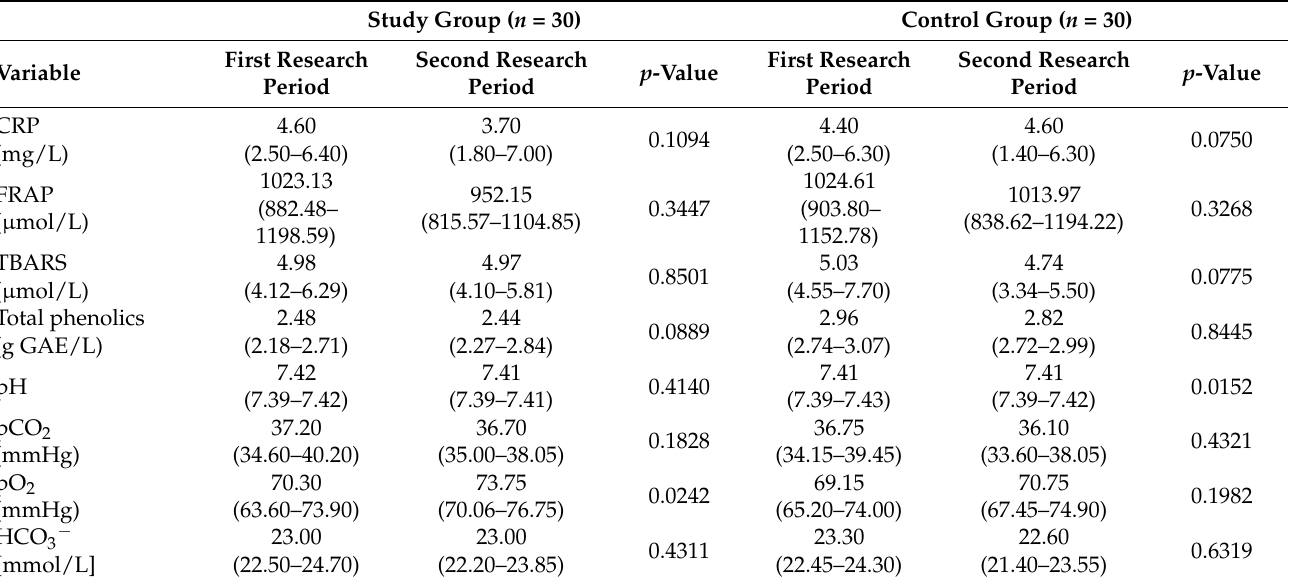
Table 2. The effect of exercises with oxygen supplementation on plasma biochemical indicators and arterial blood gases (Me (Q1–Q3)) in obese